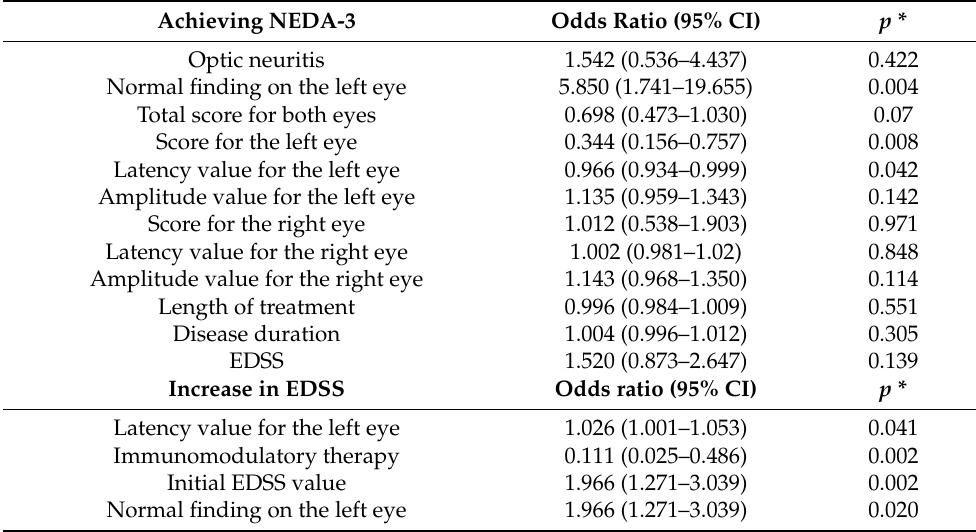
Table 4. Examined factors for achieving NEDA-3 and increase in EDSS. Achieving